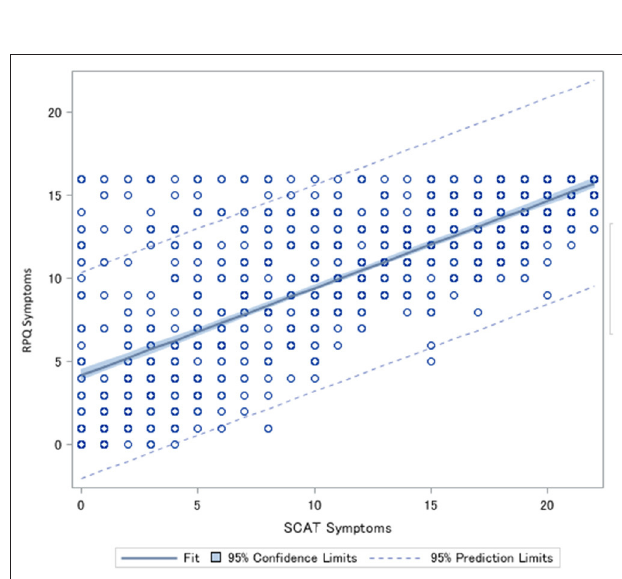
FIGURE 2 | Spearman correlation between the number of symptoms endorsed on the Rivermead Post-Concussion Symptoms Questionnaire (RPQ) and the number of symptoms endorsed on the Sports Concussion Assessment Tool (SCAT). Rho = 0.77 p < 0.0001.